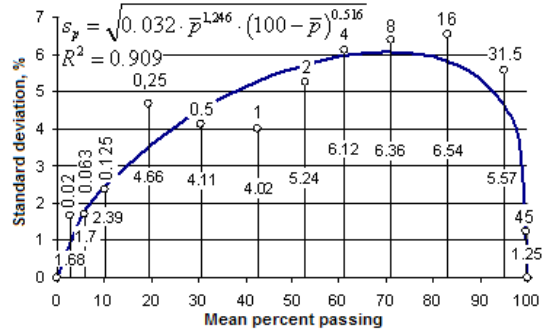
Fig. 7. Correlation between the parameters of ASB mixture gradation variation ( p s ) and position ( p ) with equation of homogeneity